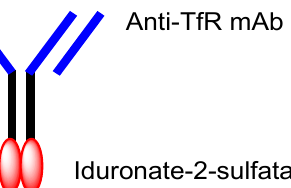
Figure 5. The structure of idursulfase beta, composed of anti-TfR (transferrin receptor) mAb (monoclonal antibody) and iduronate-2-sulfatase.